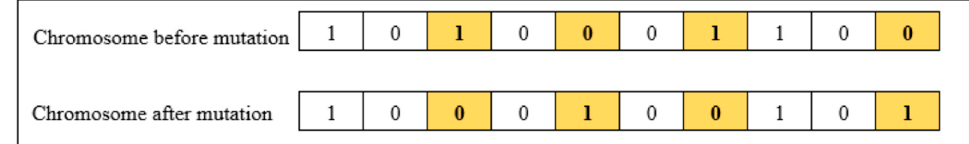
Figure 2. Mutation example with 4 genes to be mutated (genes at index 3, 5, 7, and 10). New Population. After the crossover process, and after the mutation process are completed, the new population is ready for the next iteration of the Genetic